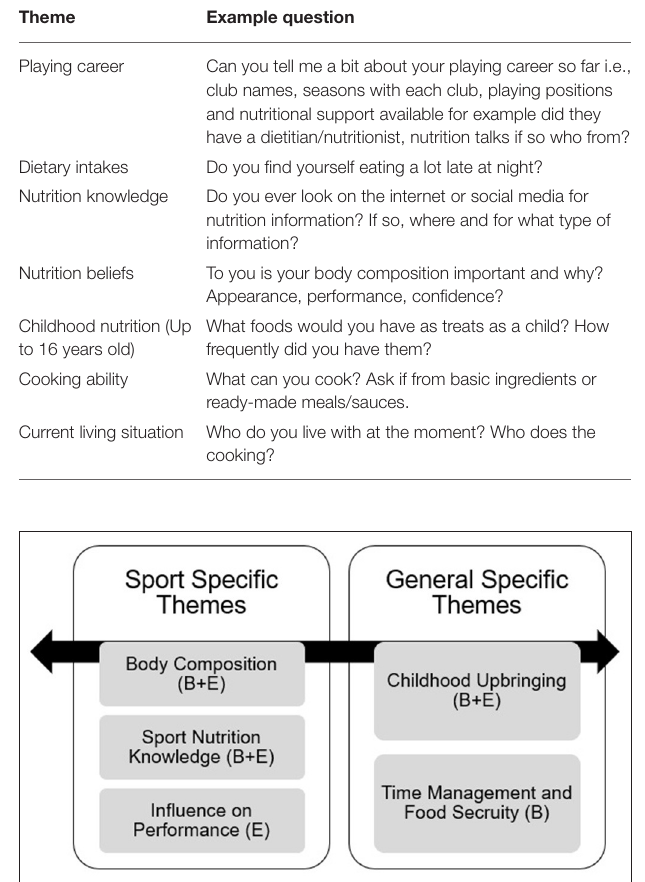
FIGURE 1 | Sport and general specific themes from thematic analysis of elite RU player’s nutrition interviews. E, Enabler; B,